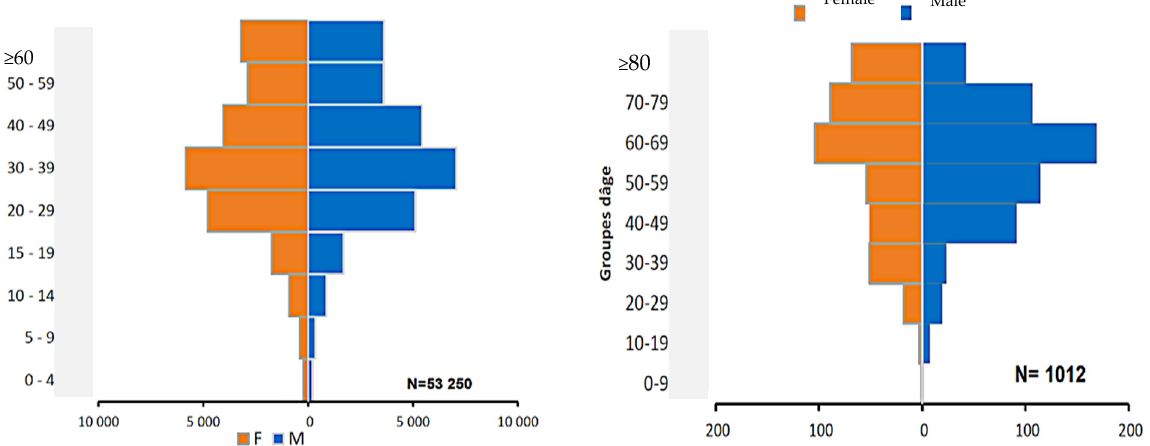
Figure 4. Left : Distribution of cumulated confirmed cases of COVID-19 by age group and gender in Cameroon as of 23 June 2021 [25]. Right : Distribution of deaths due to COVID-19 infection by age group and gender in Cameroon as of 23 June 2021 (after [34]).